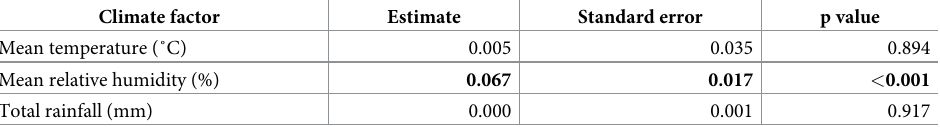
Table 5. Multivariable regression analysis of climatic factors associated with scrub typhus from country wide case counts, using climate data from Vientiane Capital (1,286 patients). Model includes average temperature, average relative humidity and total rainfall.